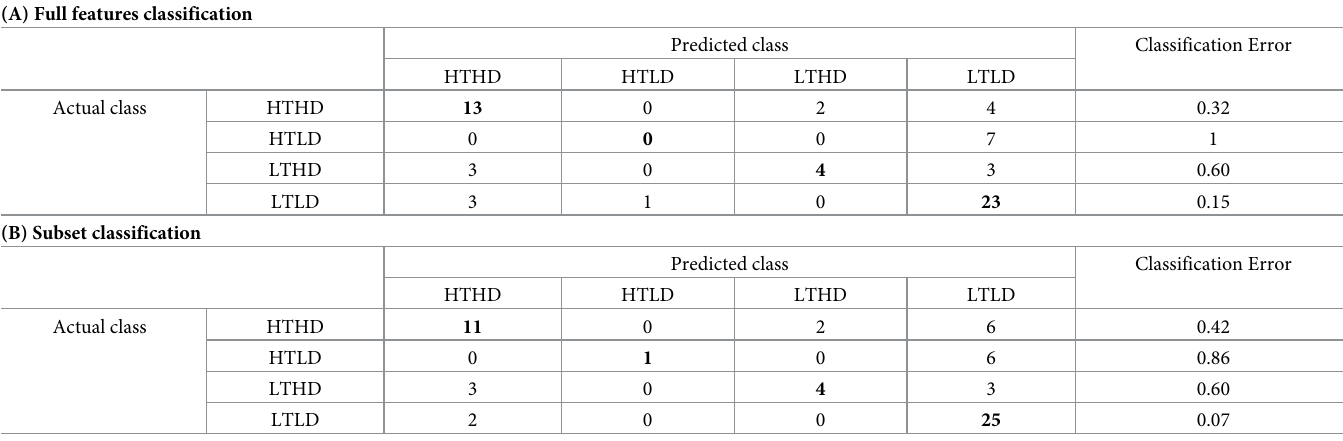
Table 2. RF Confusion matrices for the four vocal